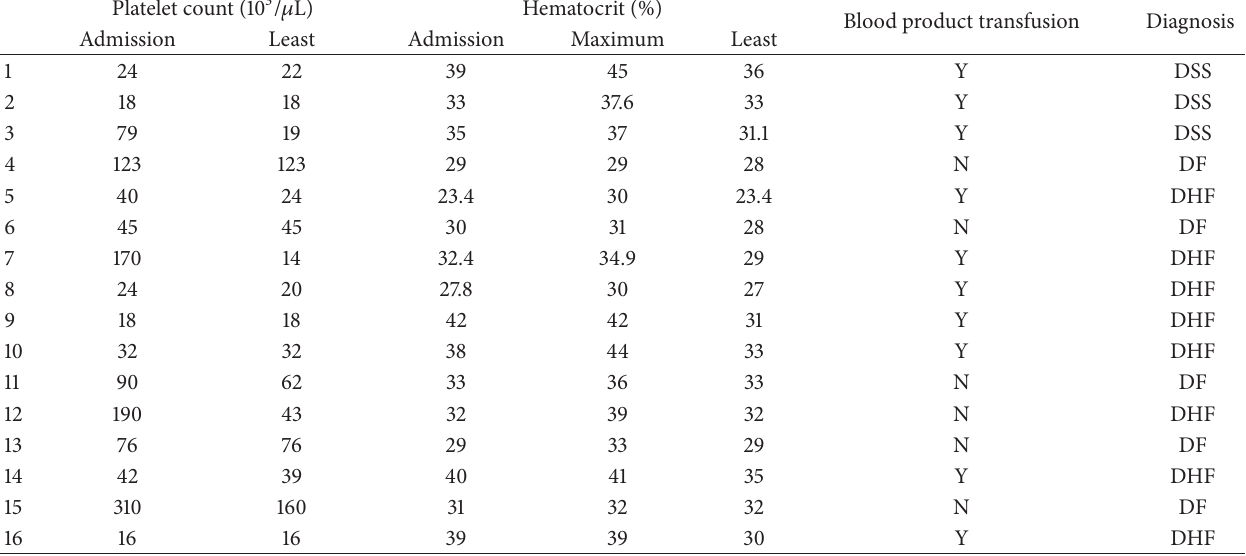
Table 2: Hematological indices and their variation during hospital stay. Platelet count (10 3 / 𝜇